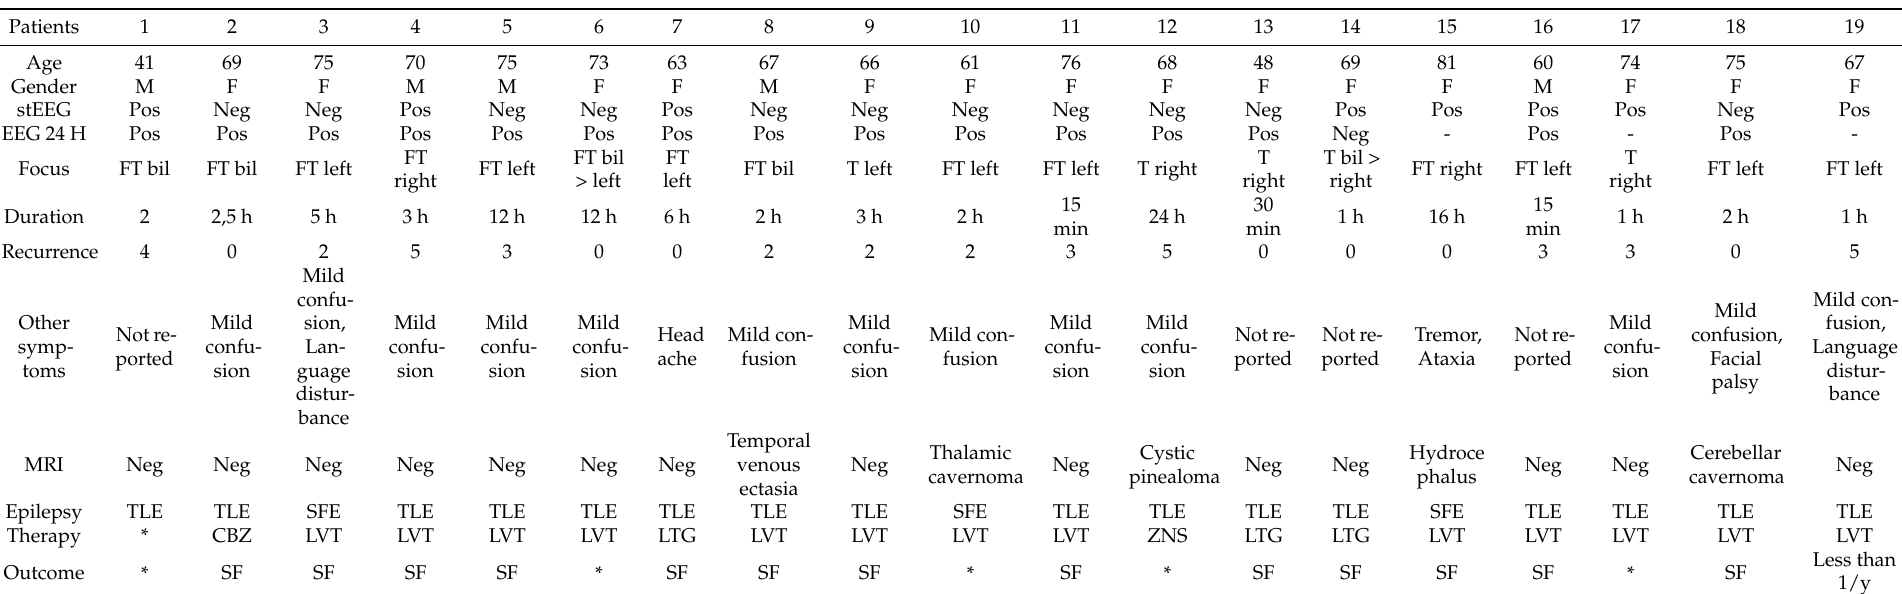
Table 1. Clinical, demographic and EEG characteristics of our TEA